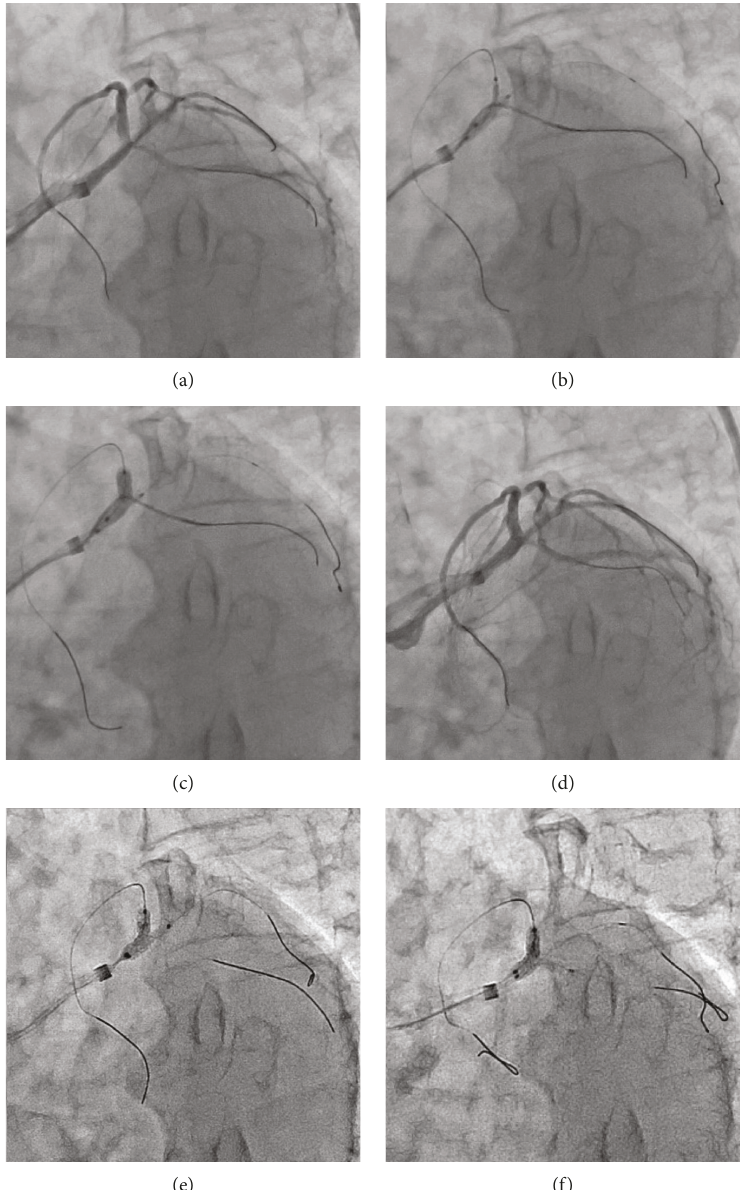
Figure 2: Stent implantation using the simultaneous jailed balloon and jailed Corsair technique. (a) Left coronary angiogram of the left anterior oblique caudal view before stent implantation. (b) The side branch balloon in the intermediate branch was initially in fl ated. (c) The main branch stent balloon was in fl ated, which jailed the side branch semi-in fl ated balloon in the intermediate branch and the Corsair Pro microcatheter in the left circum fl ex artery. (d) Blood fl ow was preserved in both side branches after stenting. (e, f) Final kissing balloon in fl ations were